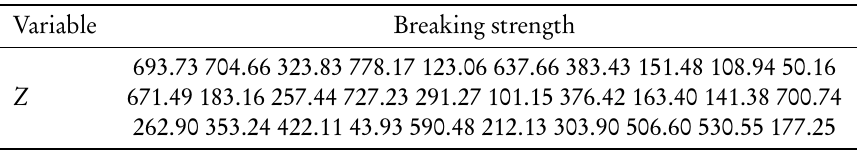
Breaking strength of jute fiber of gauge length 10 mm (Z).